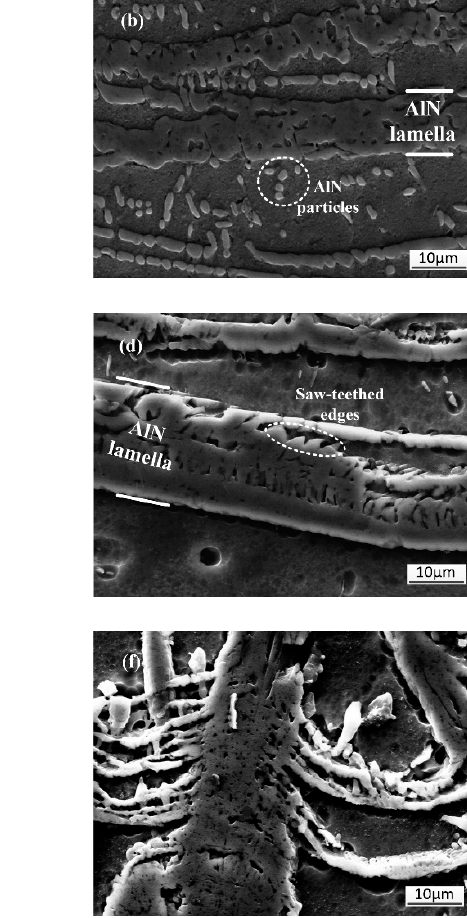
Figure 7. SEM micrographs of the lamella regions. ( a ) AlN-6082. ( b ) Increased magnification micrograph in ( a ). ( c ) AlN-1060. ( d ) Increased magnification micrograph in ( c ). ( e ) A dendrite-like